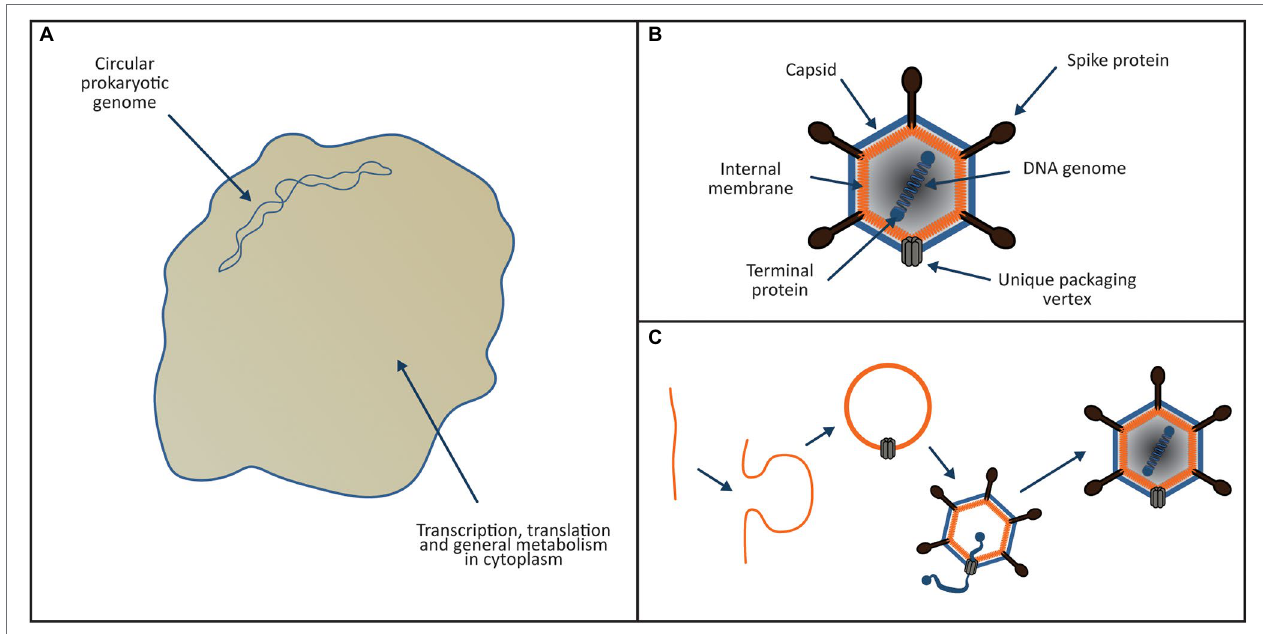
FIGURE 1 | Proposed ancestors of the eukaryotic cytoplasm and nucleus. (A) Archaeal ancestor of the eukaryotic cell was a bona-fide archaeon of the Asgard group. It possessed a small circular genome located directly in the cytoplasm, transcription and translation were linked and it encoded its own translational apparatus, ESCRT system and like P. syntrophicum (Imachi et al., 2020); it most likely was a syntroph. (B) The viral ancestor of the eukaryotic nucleus (and NCLDV viruses) was a PRD1-like tectilivirus that infected the ancient Asgard ancestor of the eukaryotes. It possessed a small linear chromosome (~15 kb) with inverted terminal repeats, formed icosahedral capsids and incorporated a membrane derived from the host plasma membrane into its capsid. (C) As per the model proposed by Hong et al. (2014), the tectilivirus had the ability to sharply curve membranes to create clathrin-like pits generating membrane bound vesicles that formed the basis of the viral